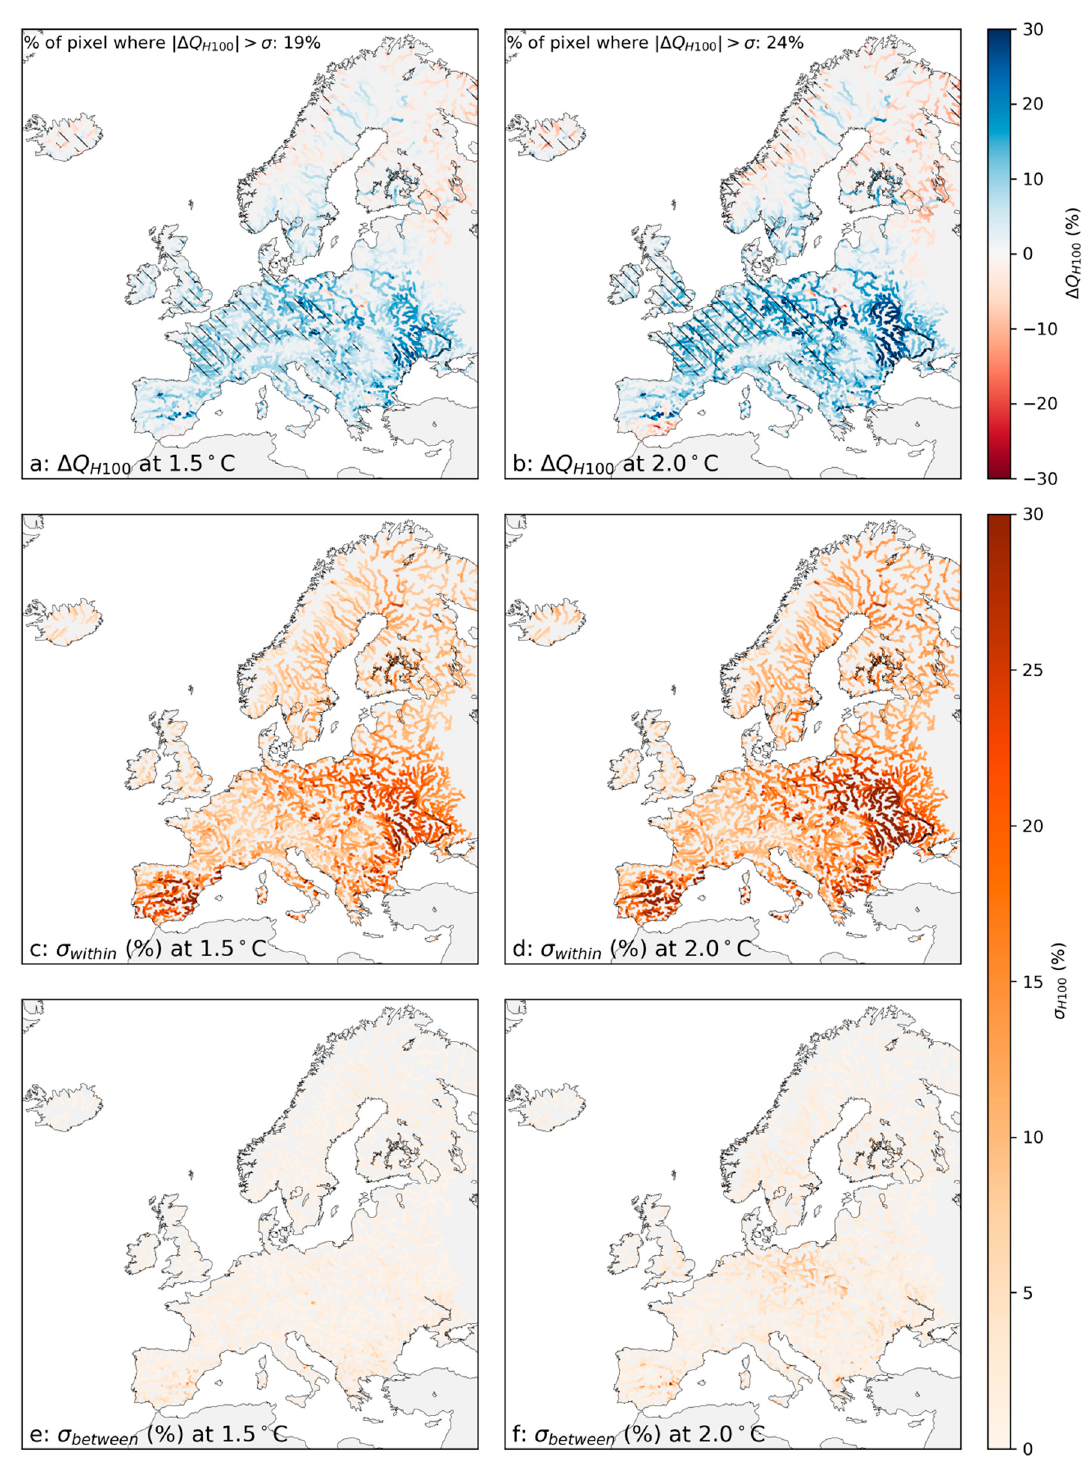
Figure 2. Projected relative change ( a , b ), within-scenario standard deviation σ within ( c , d ), between-scenario standard deviation σ between ( e , f ) of extreme high discharge (Q H100 ) at warming levels 1.5 ◦ C and 2.0 ◦ C. In the hatched area in ab, the ensemble projected change was statistically significant. Only network points with an upstream catchment area > 500 km 2 are shown.